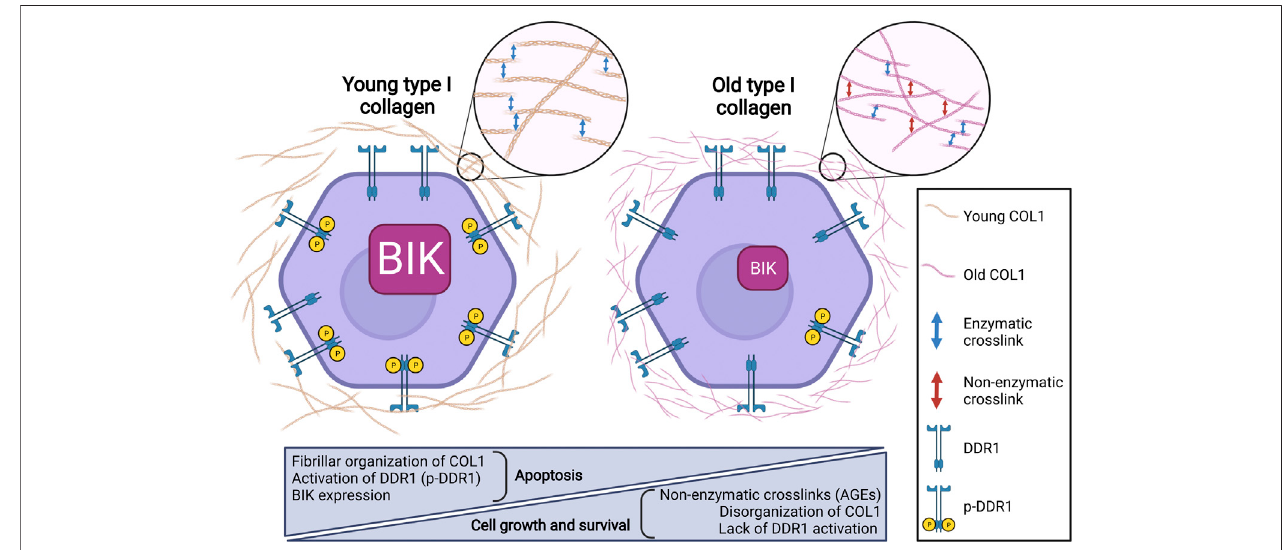
FIGURE 1 | Collagen aging impairs DDR1-induced apoptosis by decreasing BIK expression in luminal breast carcinoma.